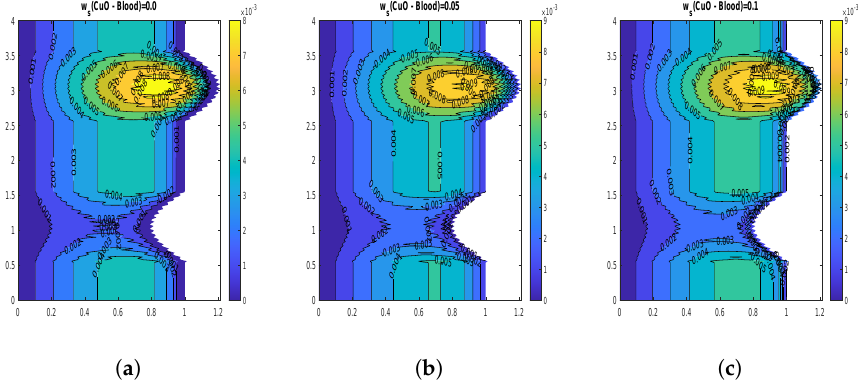
Figure 8. Blood flow patterns for wall slip velocity ( a ) w s = 0.0, ( b ) w s = 0.05, ( c ) w s = 0.1 for CuO-Blood.